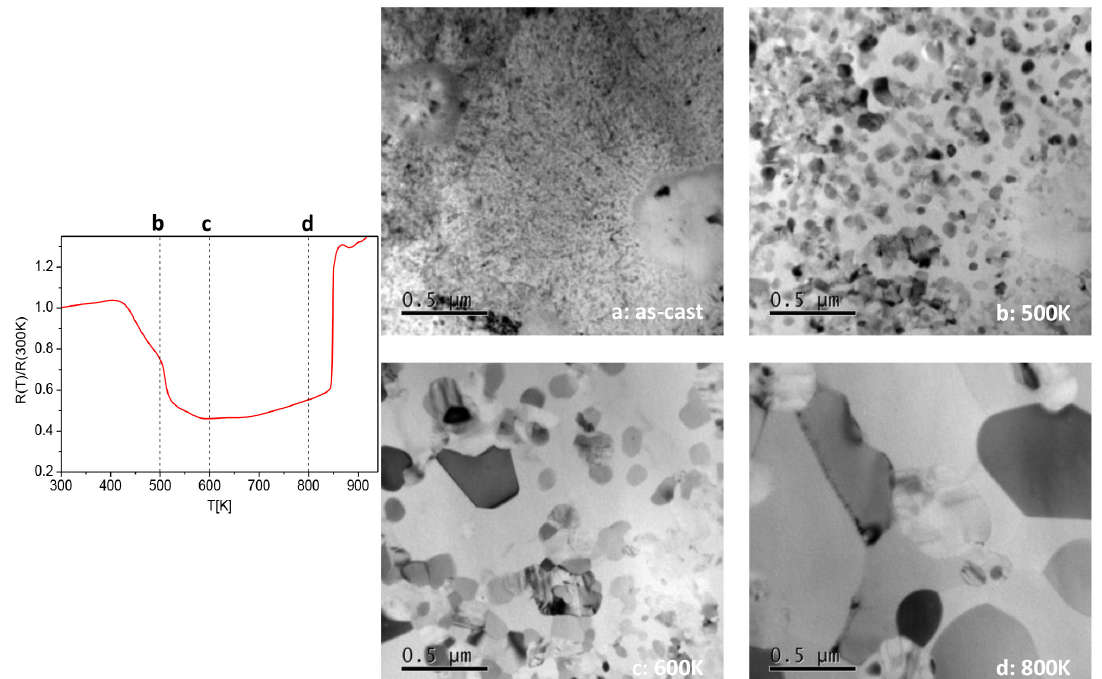
Figure 4. TEM micrographs of Al